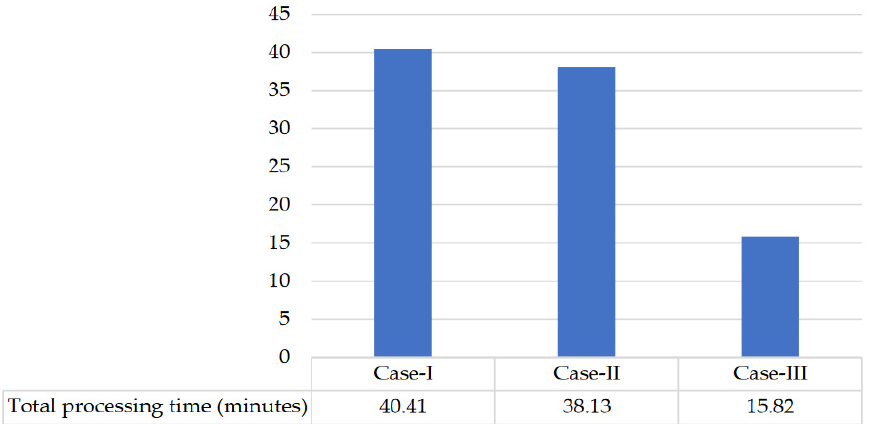
Figure 4. Total processing times (minutes) of all orders in different cases.